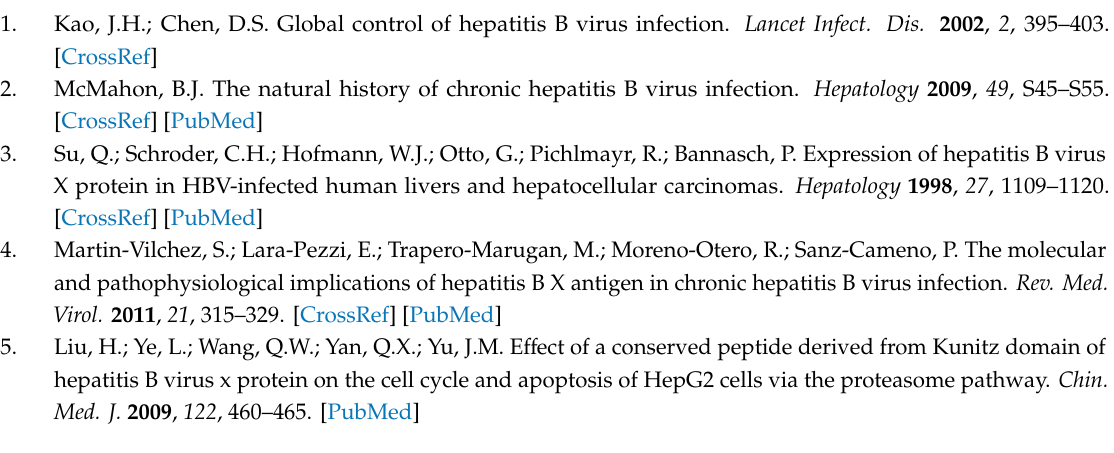
Figure S1: Expression of SHIP2 in human HCC tissue without or with HBV infection was examined by IHC analysis of the TMA, which was stained with human SHIP2 antibody, Figure S2: SHIP2 is polyubiquitinated by the E3 ubiquitin ligase SKP2 in HEK293 cells, Figure S3: Knockdown of SHIP2 did not induce resistance to Iressa, Tarceva, Doxorubicin, Sorafenib, and Paclitaxel in Hep3B cells, Figure S4: Raw data of Western blots from Figure 2, Figure S5: Raw data of Western blots from Figure 3, Figure S6: Raw data of Western blots from Figure 5,: Raw data of Western blots from Figure S2. Table S1: Used in This Study, Table S2: Sequences for SHIP2, SKP2, and HBx